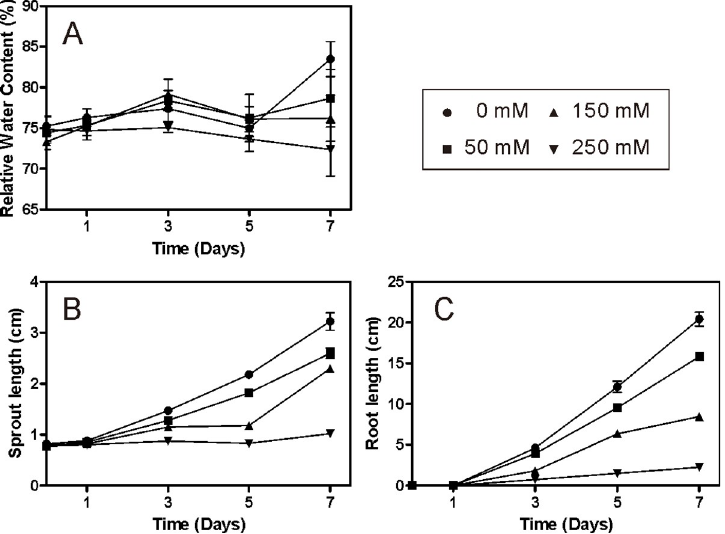
Fig 1. Effect of salt stress on Jerusalem artichoke tuber spouting. (A) Relative water content (RWC) of tuber (%). (B) Sprout length (cm). (C) Root length (cm) (Mean ± SE, n = 4).